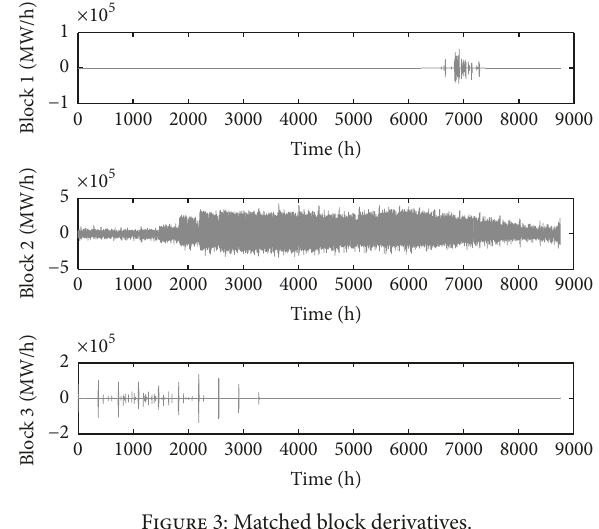
Figure 2: Discretization levels and time series match.